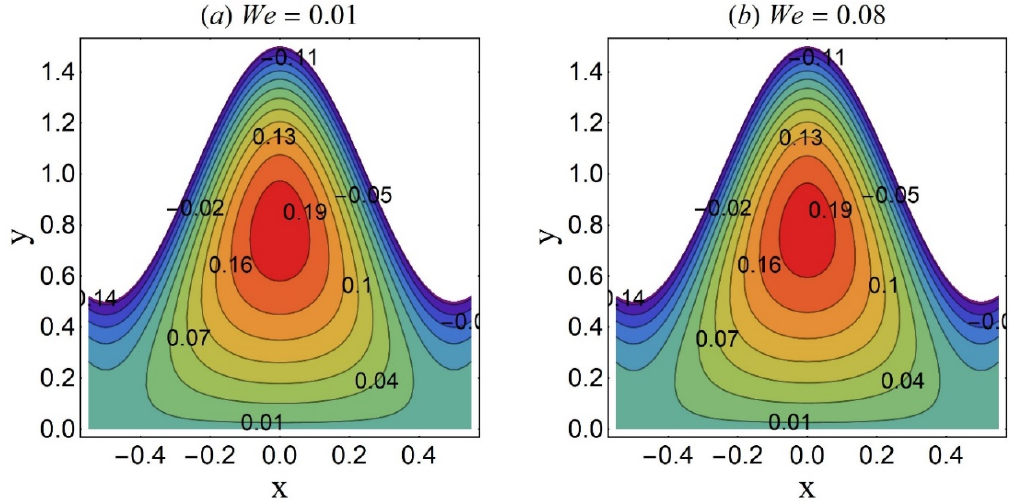
Figure 8. Streamline pattern for ( a ) We = 0.01 and ( b ) We = 0.08 at fixed values of Ha = 1 and ε = 0.4.